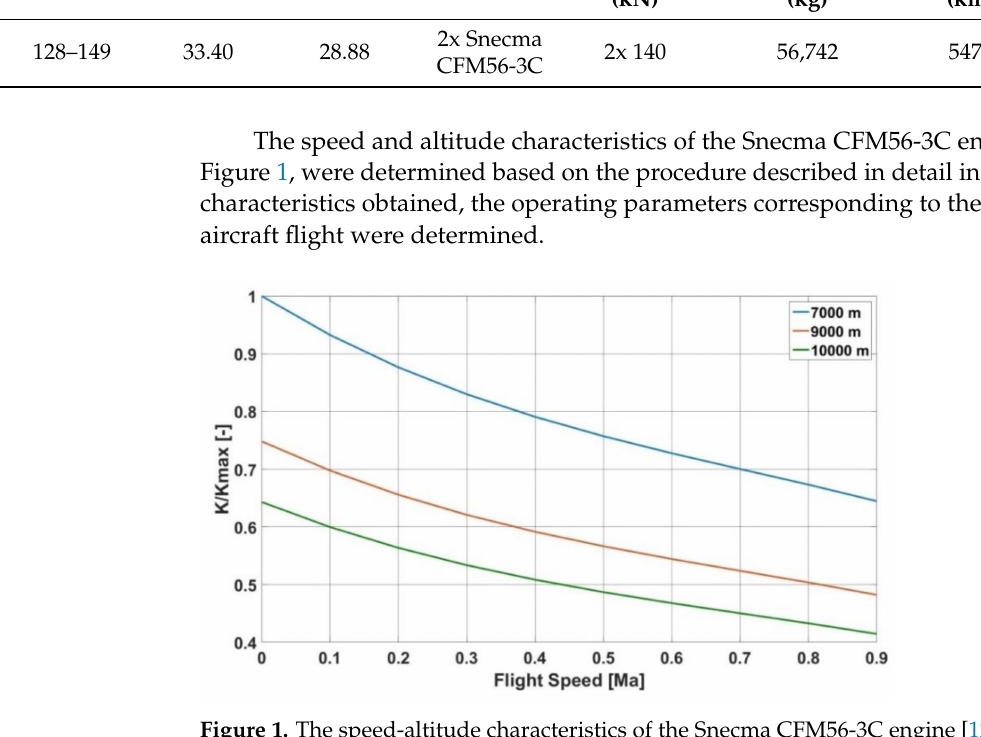
Figure 1. The speed-altitude characteristics of the Snecma CFM56-3C engine